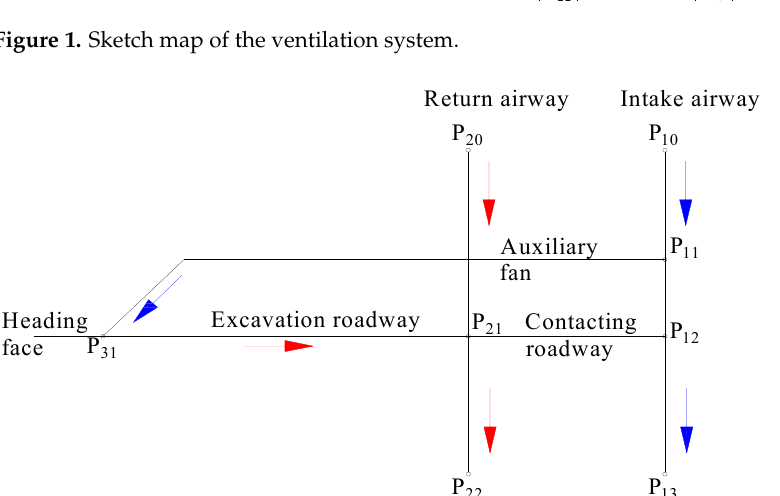
Figure 1. Sketch map of the ventilation system.